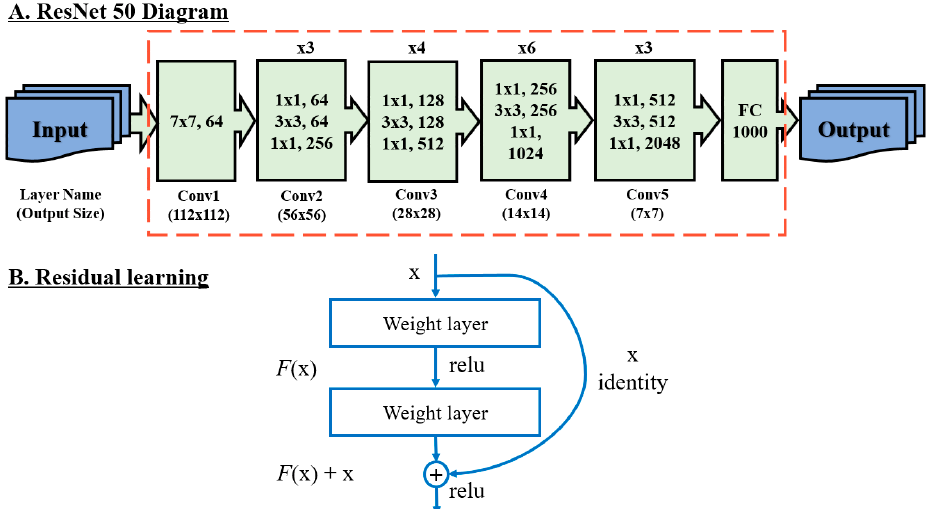
Figure 3. Architecture of residual network (ResNet) 50 and a building block for residual learning. ( A ) ResNet 50 diagram, ( B ) residual learning.